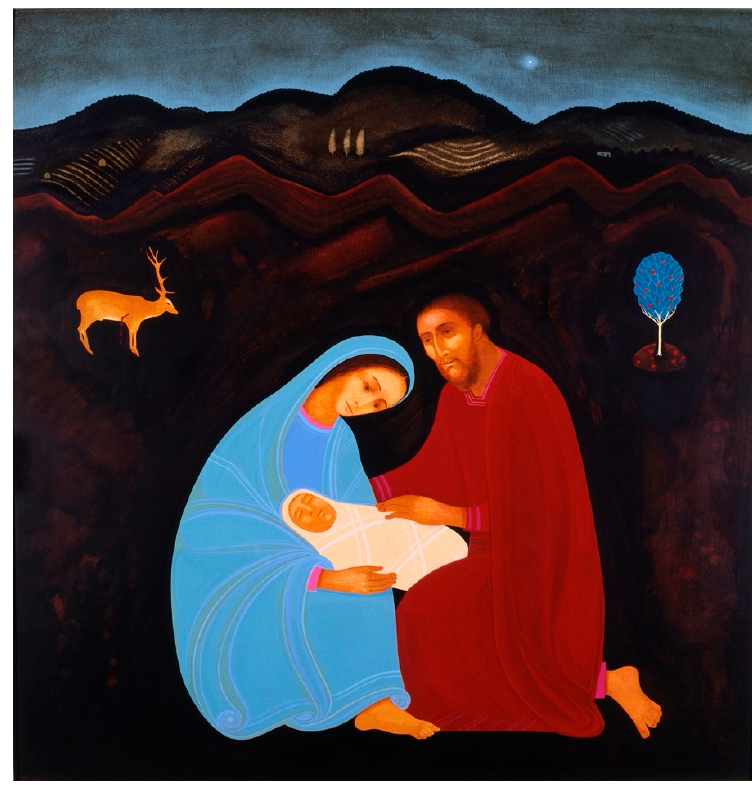
Figure 1. The Nativity.